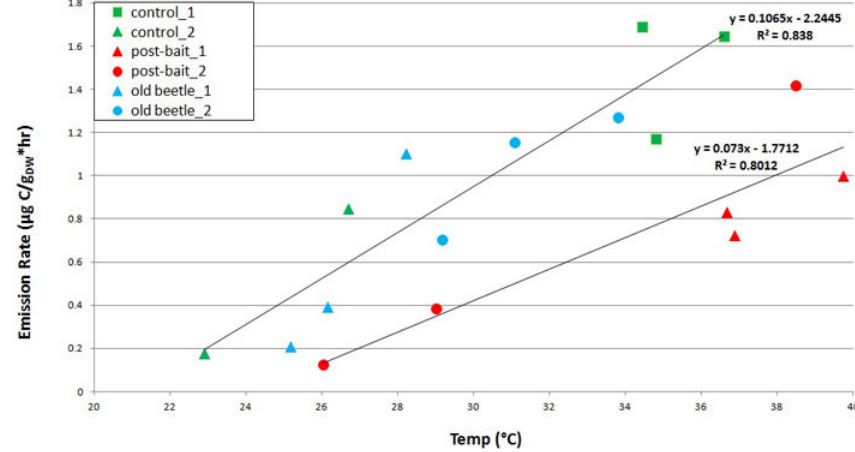
Fig. 3. MT emissions observed between 8–9 August at MRS, plotted as a function of